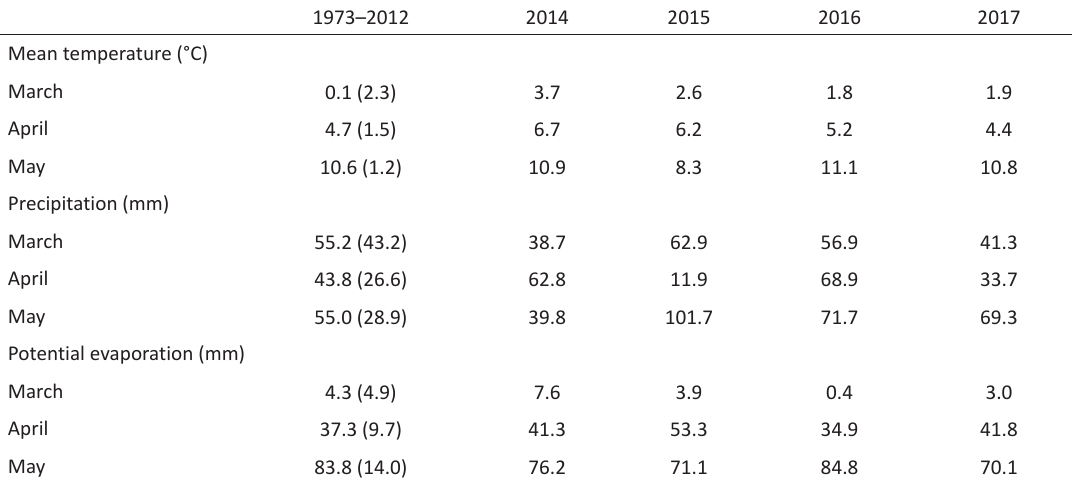
Table 1. Mean (and standard deviation) of selected weather variables at the experimental site during spring in a 30-year reference period (1973–2012) and the experimental years